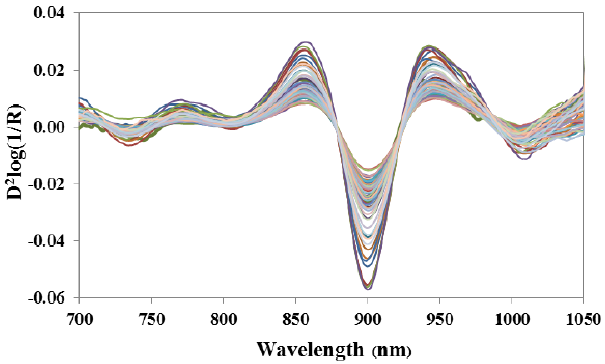
Fig. 3. Second derivative spectra of raw rubber sheet in the short wavelength region.